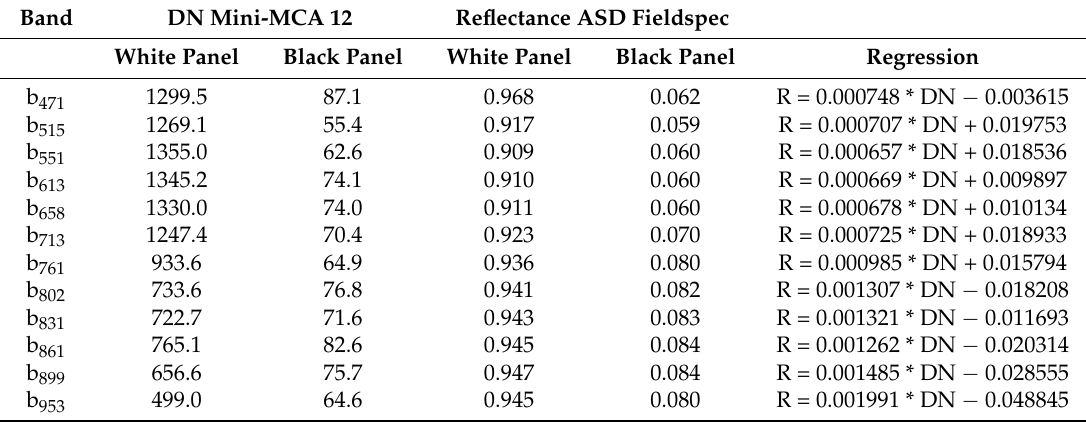
Figure 12. Relationship between ground measured reflectance of black and white calibration panels and the respective digital numbers acquired by Mini-MCA 12. ( a ) Bands 1–6; and ( b ) Bands 7–12. Raw imagery DNs of the white panels for bands 1–6 showed values close to saturation (DN 1024). After flat-field correction those pixels showed values higher than 1024. This is caused by flat-field correction factors >1, in cases where the white panel was situated close to the periphery of an image. Image DNs of the calibration panels and the corresponding ground measured reflectance are listed in Table 2 together with the respective regression. Table 2. Image digital numbers and ground measured reflectance of the white and black calibration panels in bands 1–12 and the respective regressions (empirical lines).